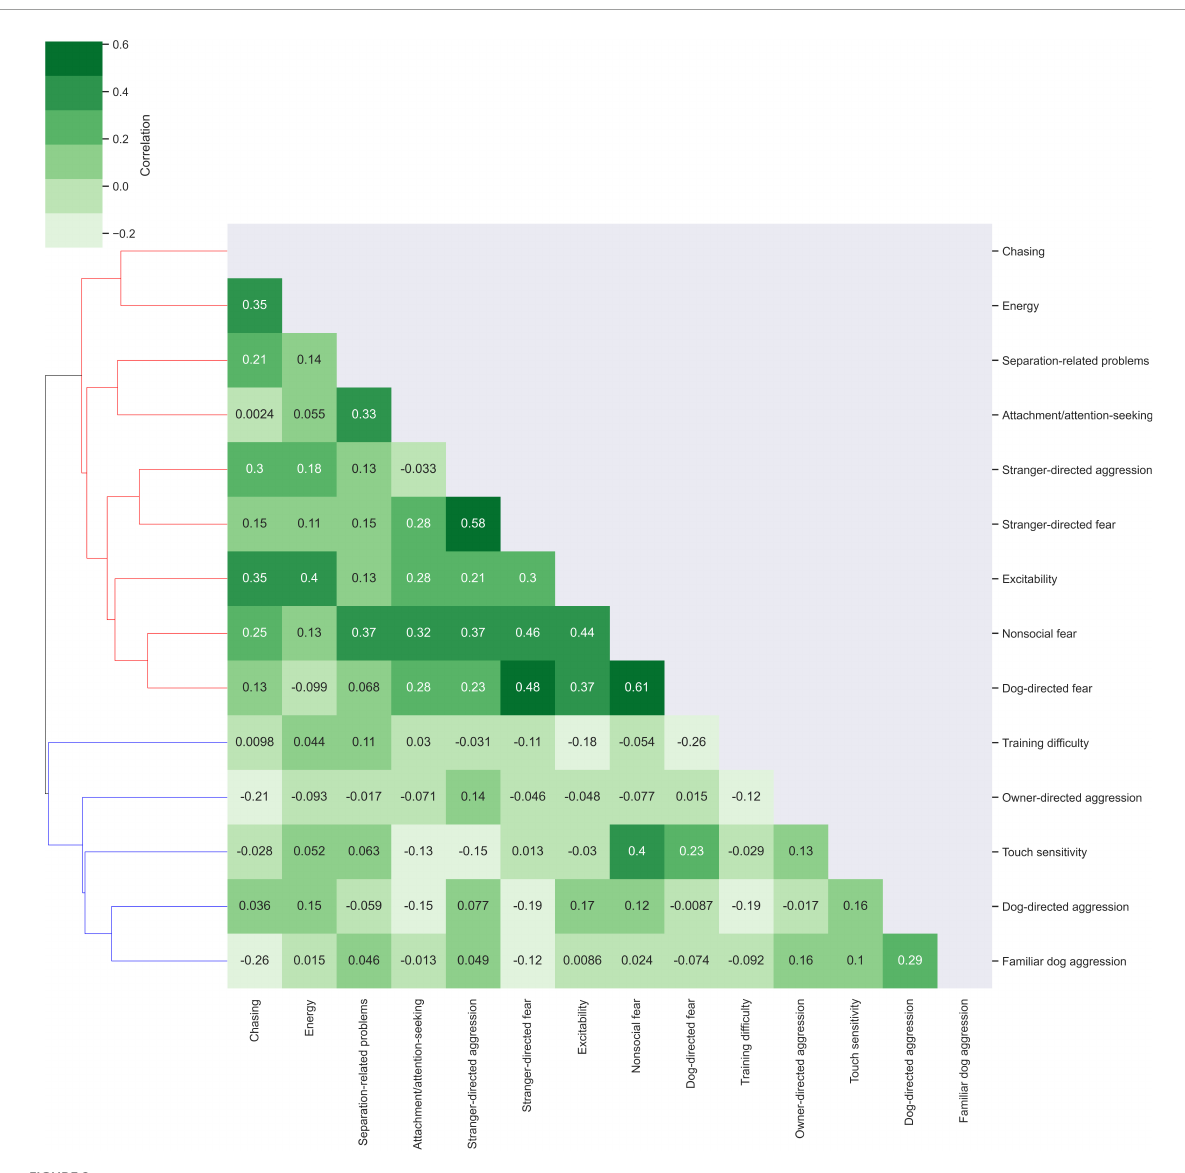
FIGURE2 Cluster analysis of correlations between traits. Traits were examined for their correlation with other traits using Python Seaborn Clustermap (Waskom, 2021). Correlations of r = 1 are depicted on the diagonal as each trait correlates exactly with itself. Lighter green shades indicate low trait correlation while darker green shades indicate correlations closer to 1. Cluster 1 is colored in red on the dendrogram while Cluster 2 is colored in